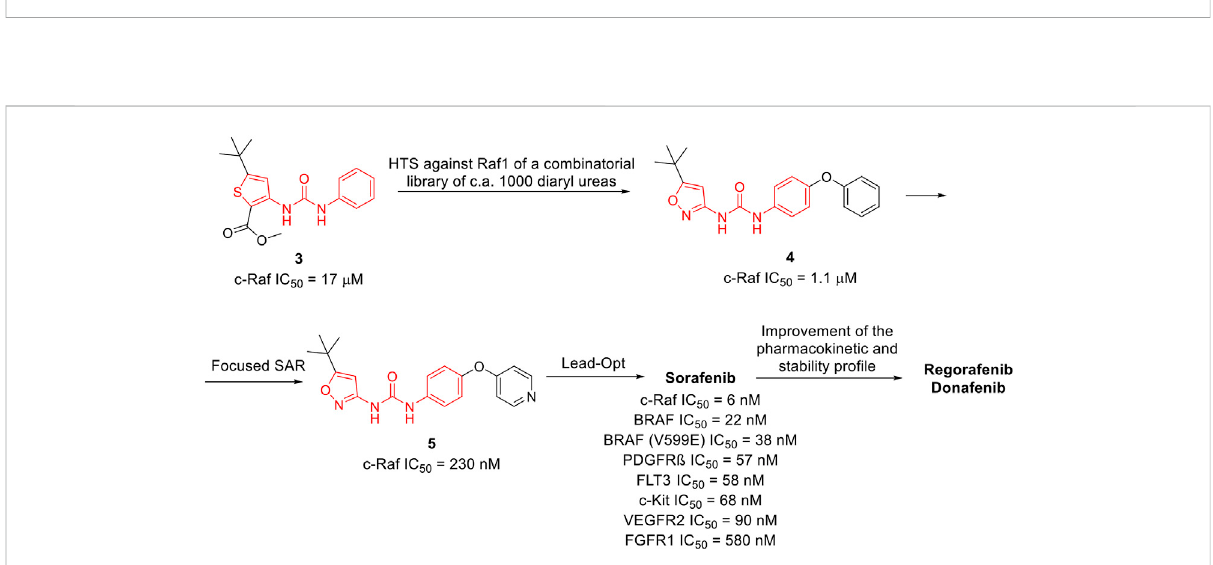
FIGURE 8 Key steps in the optimization process of sorafenib starting from the fi rst identify diarylurea.